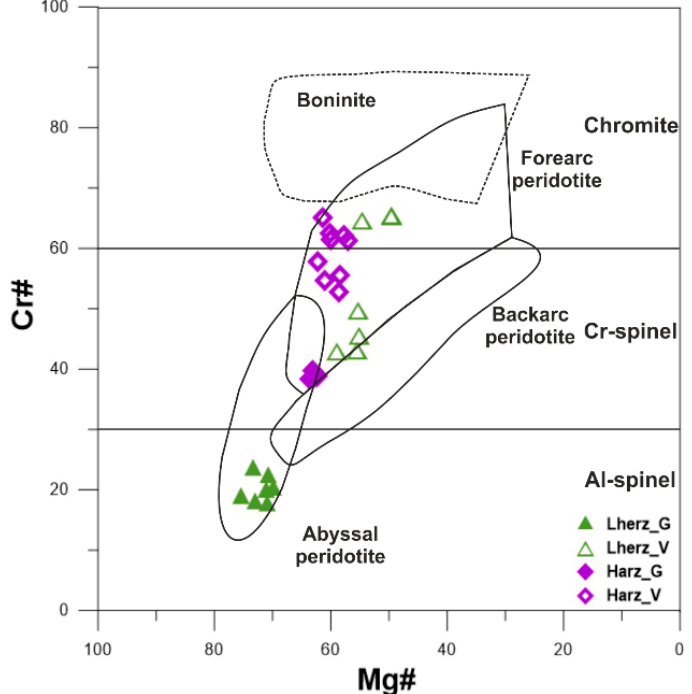
Figure 10. Cr# vs. Mg# [Cr# = 100 × Cr/(Cr + Al); Mg# = 100 × Mg/(Mg + Fe 2+ )] diagram of spinel- group minerals hosted within the Veria–Naousa and Gerania peridotites. Fields of boninite [95,96], forearc peridotite, backarc peridotite, and abyssal peridotite [97] are shown for comparison.